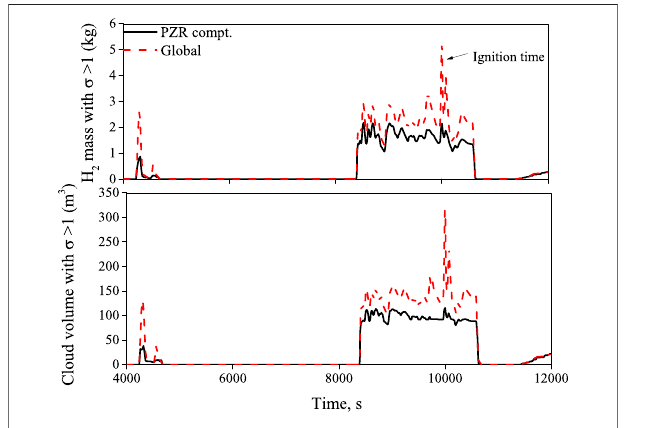
FIGURE 9 | Volume and hydrogen inventory of σ